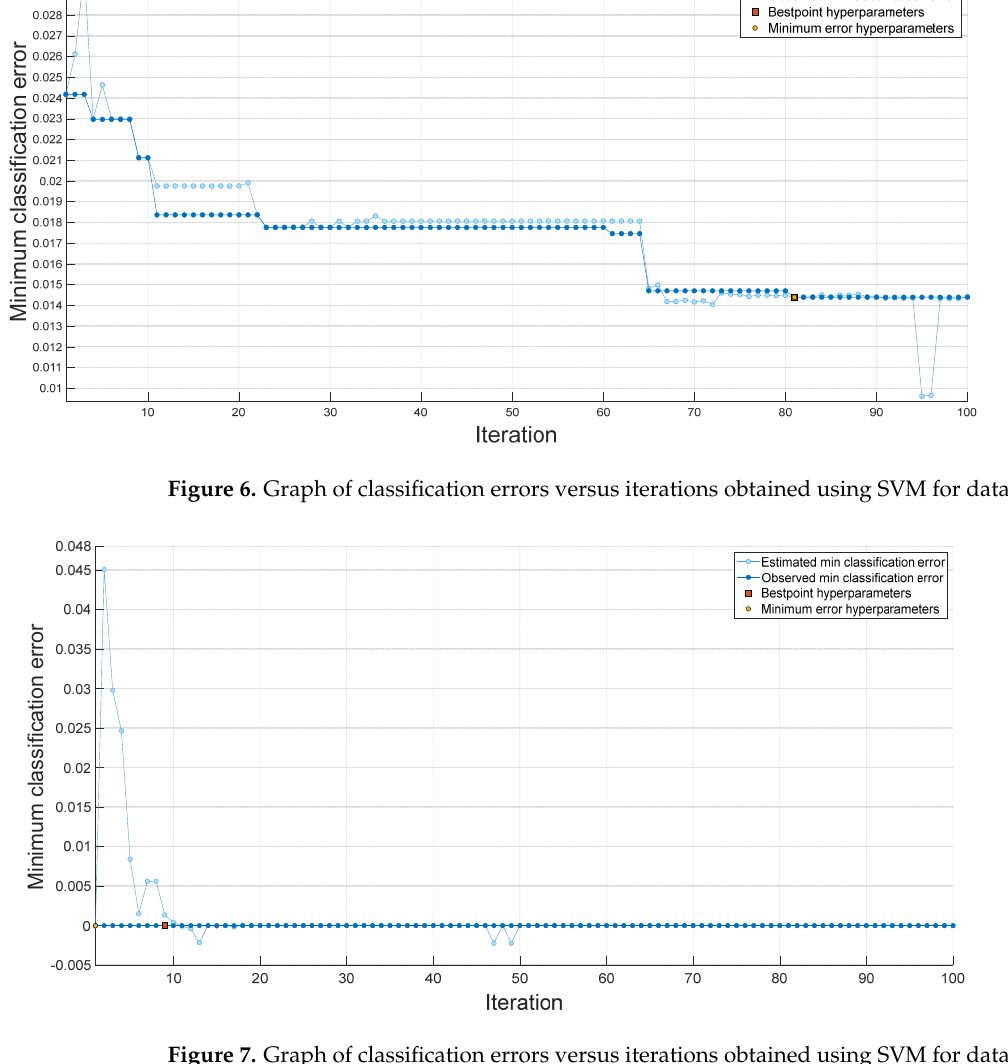
Figure 7. Graph of classification errors versus iterations obtained using SVM for dataset 2. Table 2. Summary of hyperparameters used for datasets I and II.